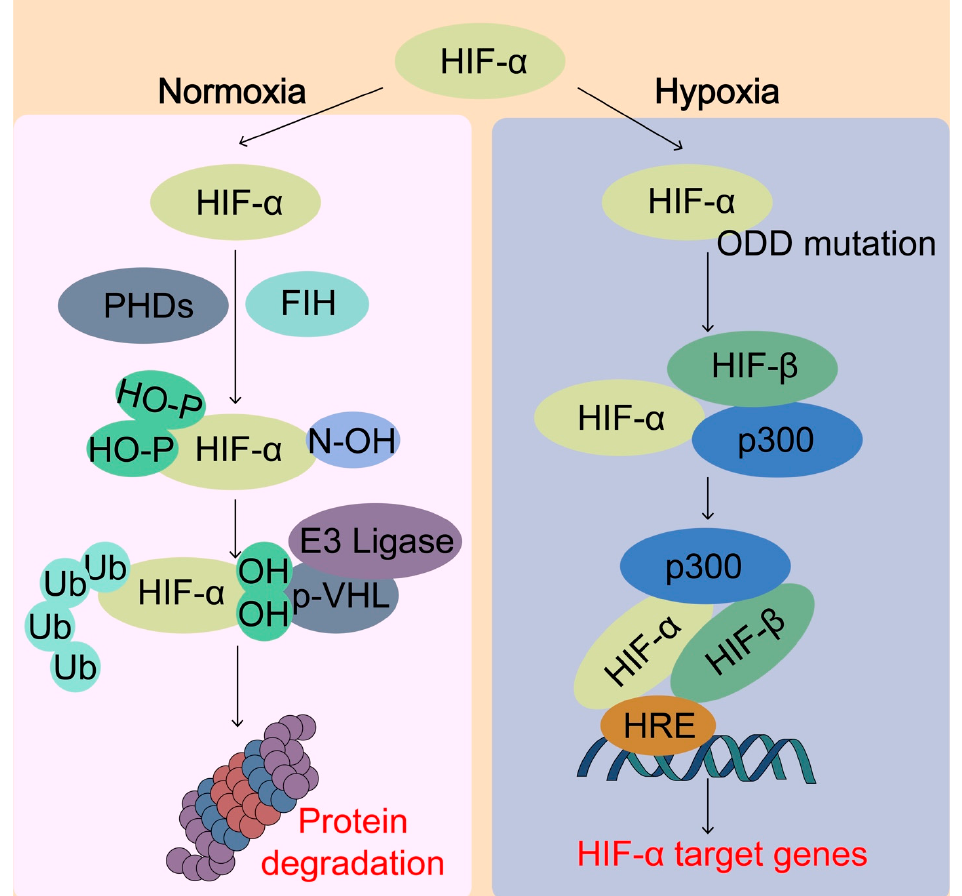
Figure 4. Sensing of O 2 by hypoxia-inducible factor (HIF) system. Under normal oxygen conditions (normoxia), the HIF- α protein is rapidly hydroxylated by the prolyl hydroxylases (PHDs) enzymes, which enables the binding of von Hippel–Lindau (pVHL) E3 ubiquitin ligase complex, leading to ubiquitination and proteasomal degradation of HIF- α . On the other hand, the factor inhibiting HIF-1 (FIH) catalyzes specific asparagine hydroxylation of HIF- α , which blocks the transcriptional co-activator p300 from binding with HIF- α , thereby inhibiting HIF transcriptional activity. Under hypoxic conditions, the activity of PHDs and FIH is inhibited due to lack of O 2 , thereby lack of hydroxylation of HIF- α . Unhydroxylated HIF- α translocates to the nucleus, forms a complex with HIF- β and p300 targeting hypoxia response element (HRE), and activates transcription of HIF target genes. pVHL, von Hippel-Lindau tumor-suppressor protein; HIF, hypoxia-inducible factor; ODD, oxygen-dependent degradation domain; p300, Histone acetyltransferase